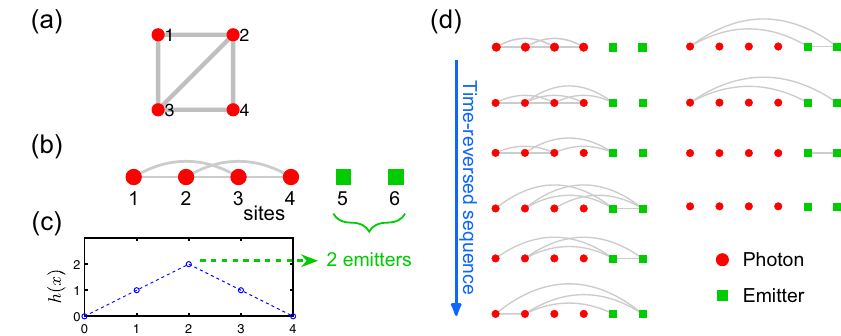
Fig. 1 Illustration of the protocol solver algorithm. a An example of a 4-photon graph state. b The graph is mapped to a 1D lattice. c The height function is computed and found to have maximum value 2, implying 2 emitters are needed. These are added to the 1D lattice. d Starting from the target state and decoupled emitters, a time-reversed sequence of emitter gates, photon absorption events, and time- reversed emitter measurements is constructed, until all qubits are disentangled. Further details about this example can be found in the Supplementary